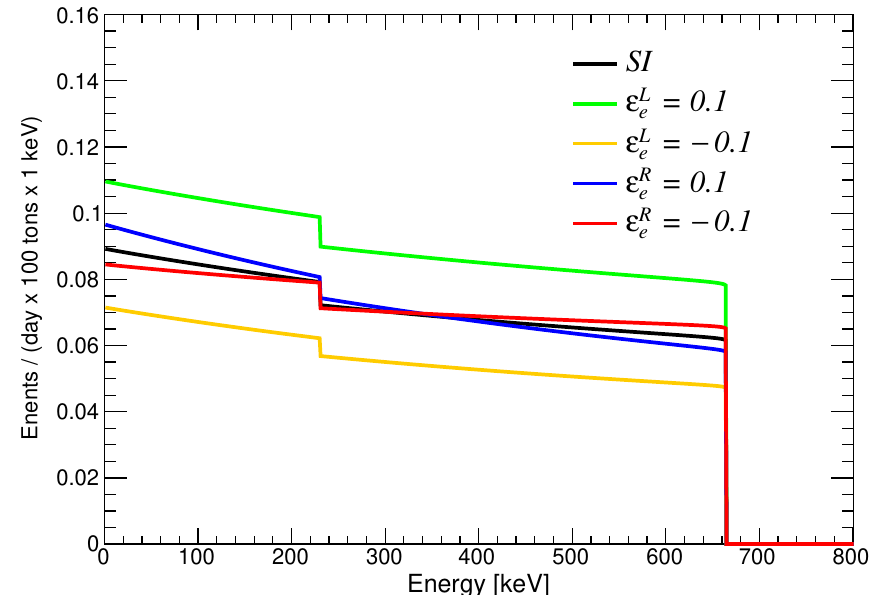
Figure 2 . The distortion of the electron recoil spectrum, eq. (3.1), for the two monochromatic 7 Be solar neutrino lines ( E = 0 : 384 MeV and 0 : 862 MeV) due to non-zero values of " L e(cid:11)ect of the (cid:12)nite energy resolution of the detector is not included.